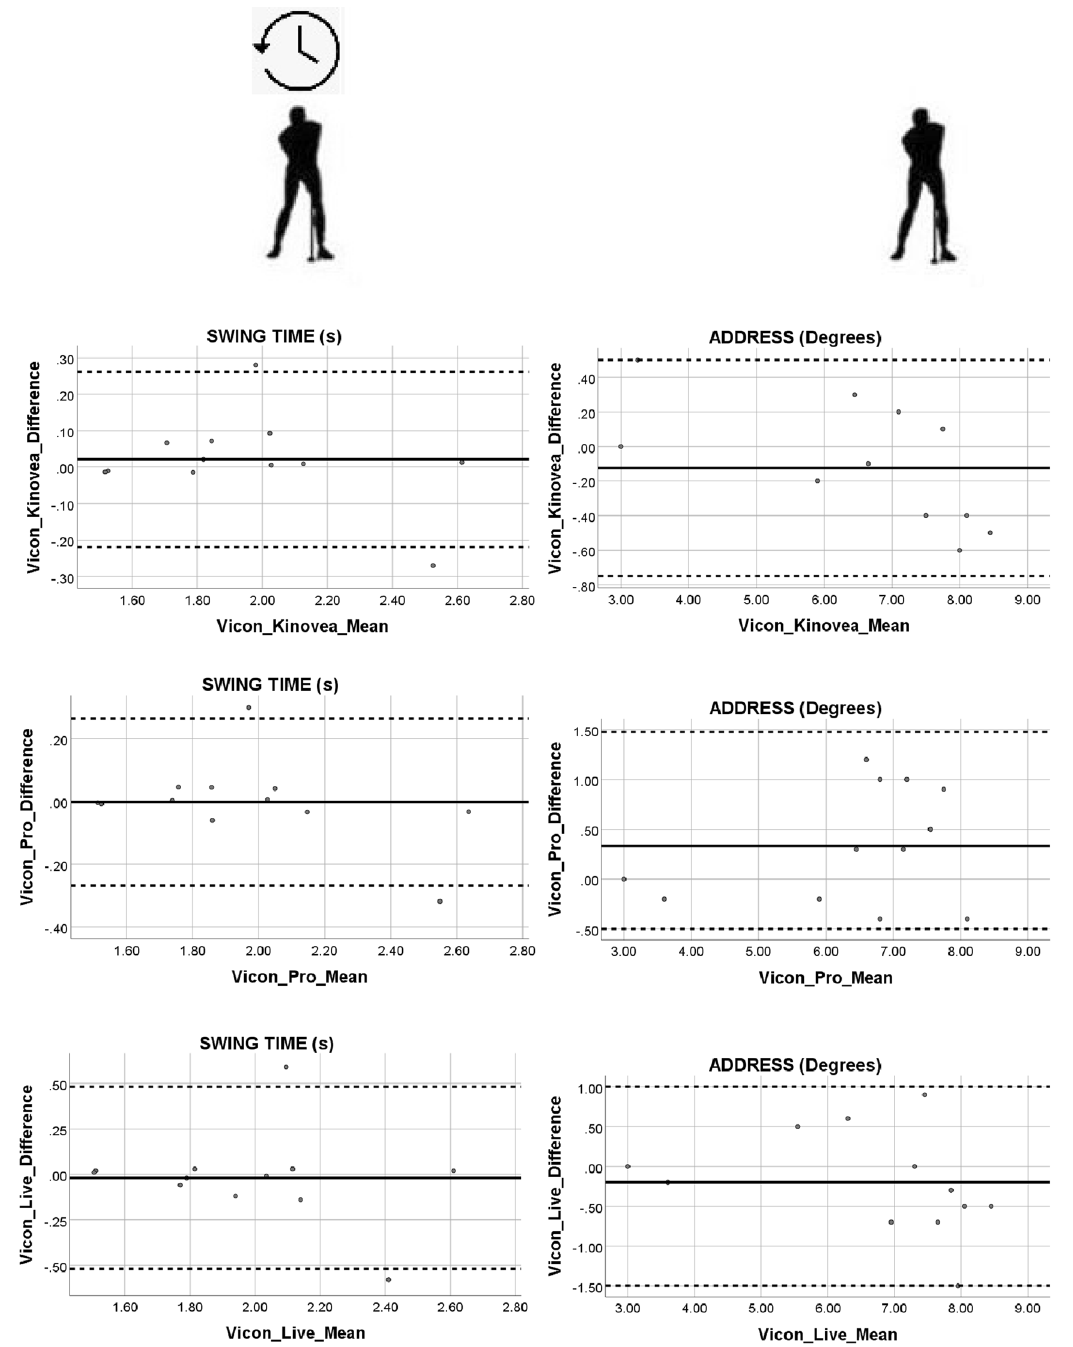
Figure 2. Swing time and address difference against mean for software data. Swing time was measured in seconds and address measured in joint angles